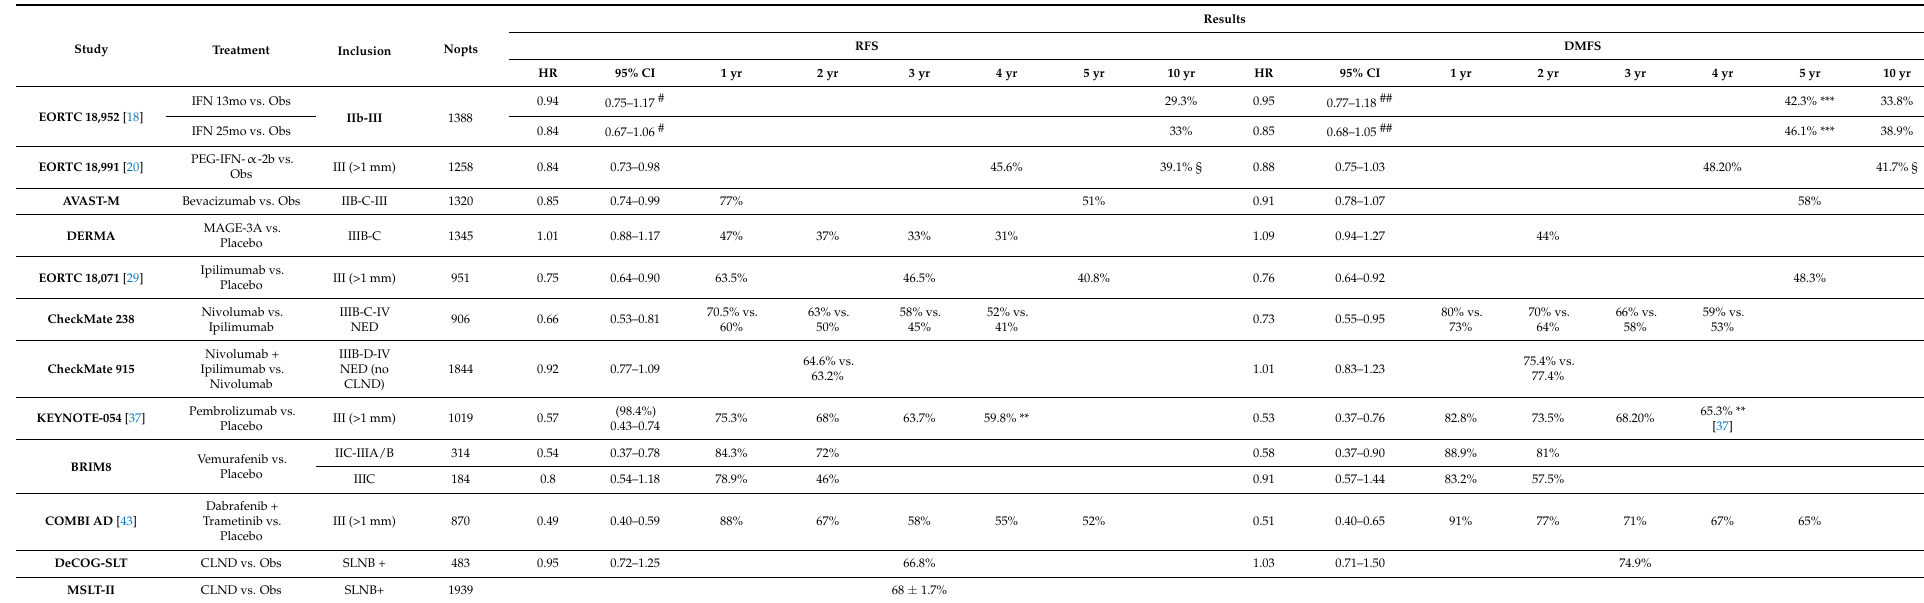
Table 2. RFS and DMFS of the treatment arm(s) in the principal studies of adjuvant